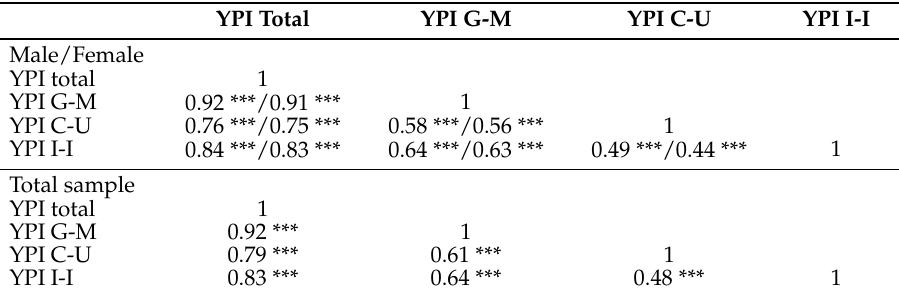
Table 3. Pearson correlation matrix for the YPI and its dimensions.